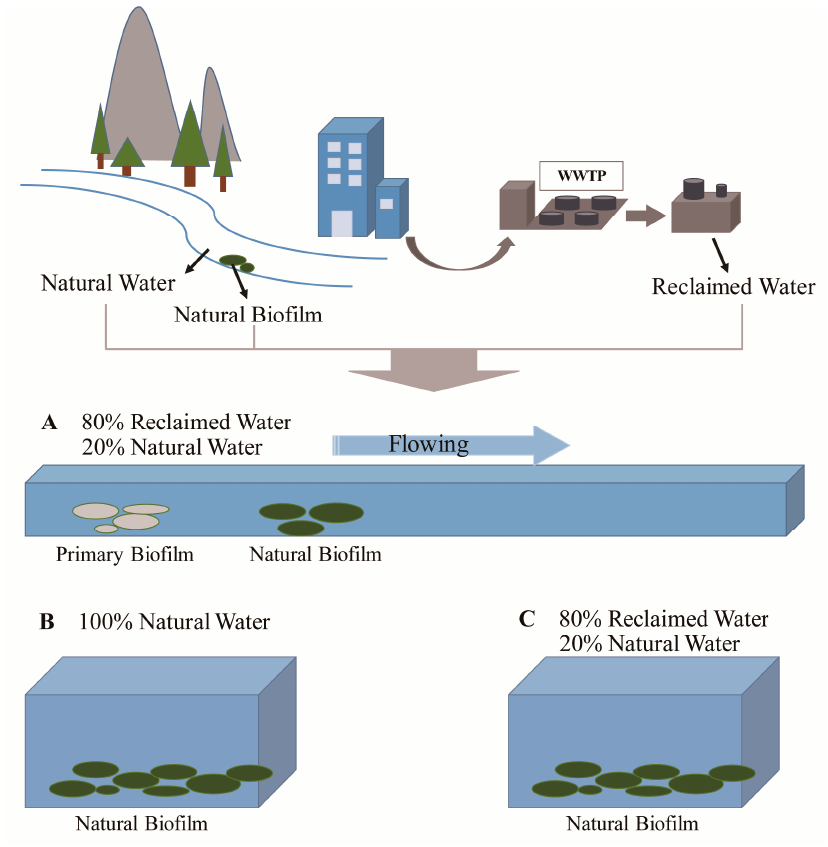
Figure 1. Water and biofilm collection and experimental design. ( A ) 80% reclaimed water, 20% natural water; ( B ) 100% natural water; ( C ) 80% reclaimed water, 20% natural water.